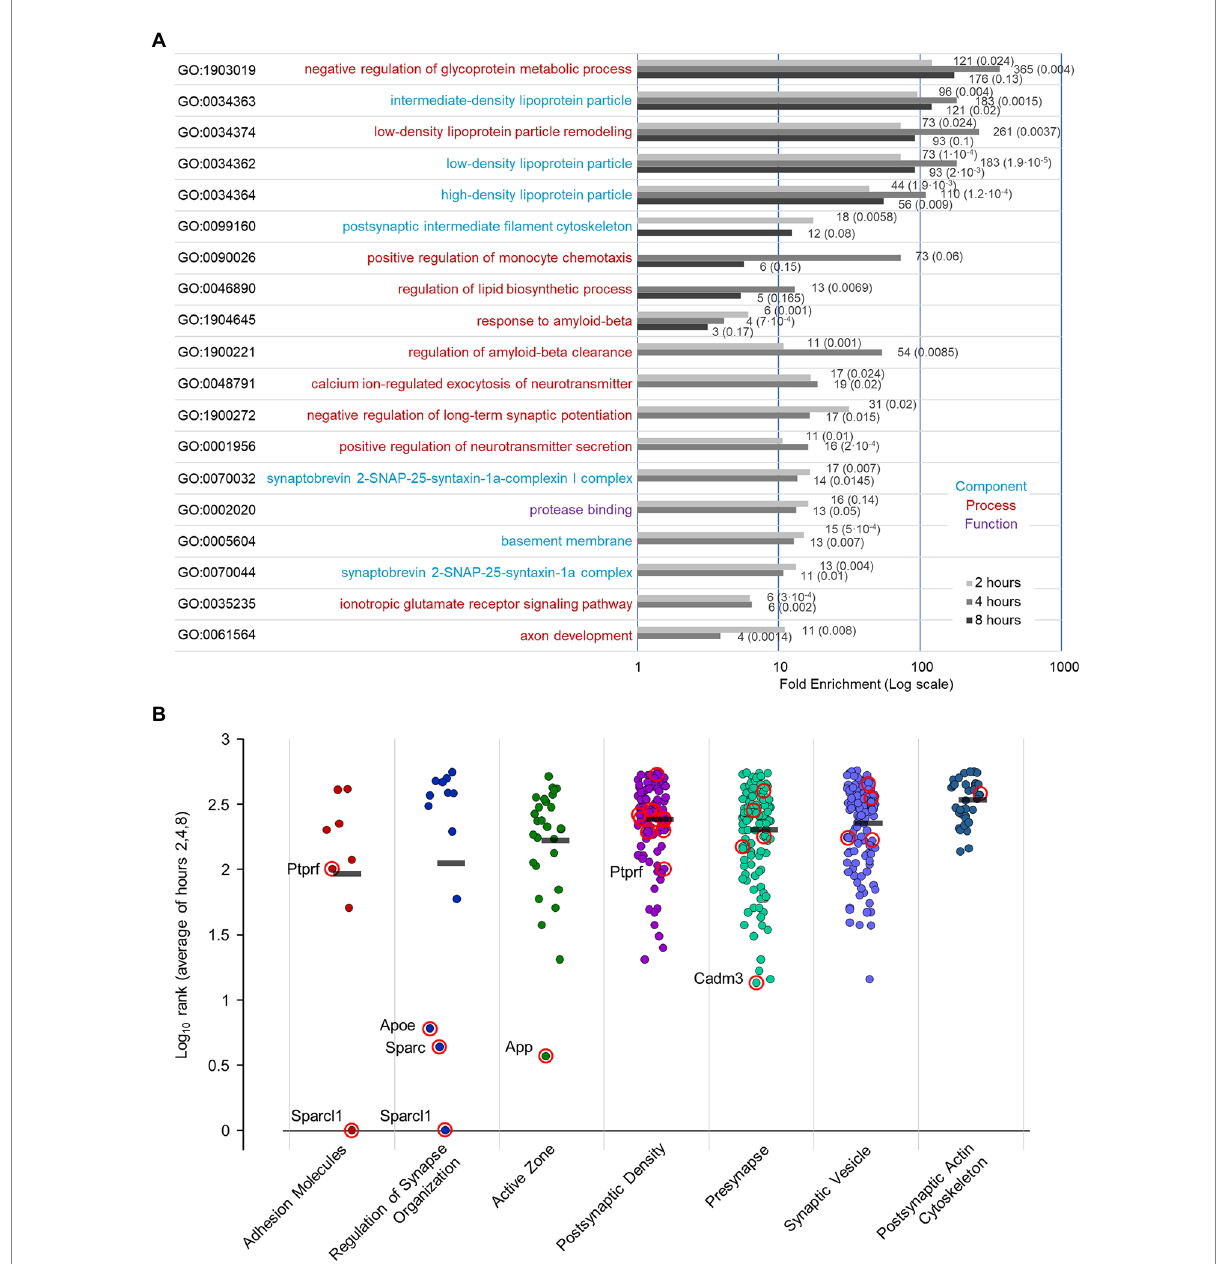
FIGURE 11 GO term enrichment following PSI treatment, and annotation of proteins with synaptic functions / categories. (A) GO enrichment analysis of proteins that were most reduced following PSI exposure. We used GOrilla (Gene Ontology enRIchment anaLysis and visuaLizAtion tool) (Eden et al., 2009; http://cbl-gorilla.cs.technion.ac.il/) to perform the enrichment analysis on filtered lists at each time point (2,4,8 hours) following PSI exposure, ranked with most decreased proteins at the top of list. The top 25% enriched GO terms are displayed along with their fold enrichment 2, 4, and 8 h following exposure to PSIs. Fold enrichment values and FDR values are indicated beside each bar. Terms already enriched at t = 0 (probably reflecting statistical artifacts related to the neuronal origin of the samples) were excluded. Further specifics on this bioinformatic analysis are provided in the Materials and Methods section. (B) Log 10 rank (average of hours 2, 4, and 8) of proteins with synaptic functions/categories following protein synthesis suppression. Proteins were ranked at each time point (2, 4, 8 h) such that proteins that decreased the most were at the top of the list. Log 10 rank average for proteins with the following synaptic functions/categories based on the SynGO knowledgebase (Koopmans et al., 2019; number of proteins in each group from our dataset, and the specific annotations selected for each group are detailed in parentheses below): Adhesion Molecules [8 proteins, synapse adhesion between pre- and post-synapse (GO:0099560)], Regulation of Synapse Organization [13 proteins, regulation of synapse organization (GO:0050807)], Active Zone [29 proteins, presynaptic active zone (GO:0048786), presynaptic active zone cytoplasmic component (GO:0098831), integral component of presynaptic active zone membrane (GO:0099059),